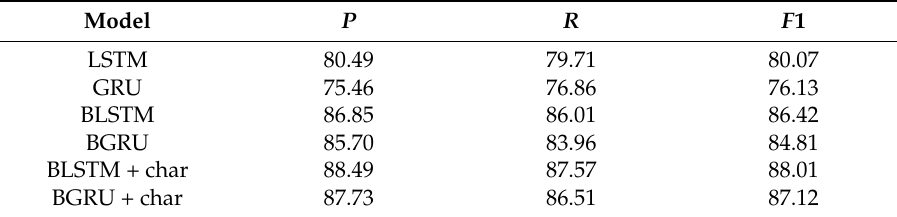
Table 1. Results obtained by our model with different